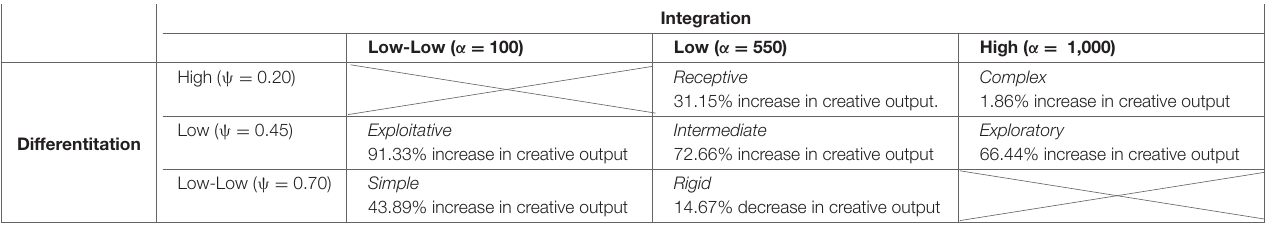
TABLE 2 | Effect of paradox treatment on creative performance for each thinking